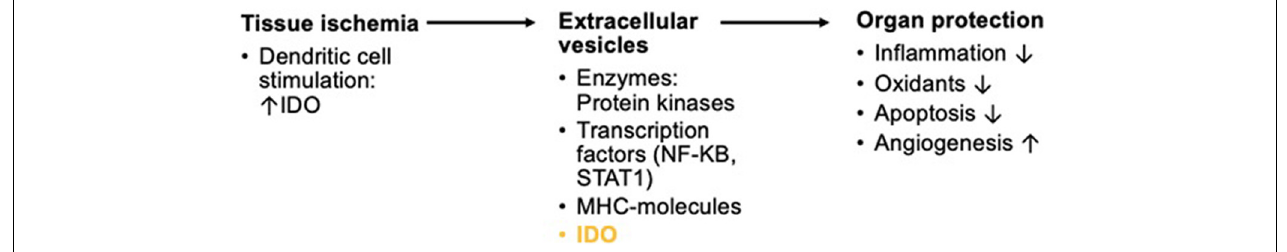
FIGURE 4 | Short overview of the physiologic background in remote ischemic preconditioning for reperfusion of anoxic organs. Ischemia triggers the activation of DCs. Inflammation by tissue ischemia induces IDO in DCs. The production of exosomes with enzymatic composites, transcription factors, major histocompatibility complex (MHC-) molecules, and IDO among many other compounds is triggered. These EVs show protective effects on organs in reperfusion.